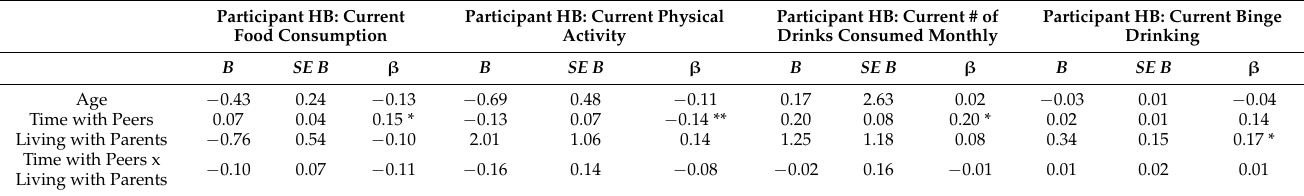
Table 3. Associations of time spent with peers and living with parents with students’ current health behavior (Hierarchical regression